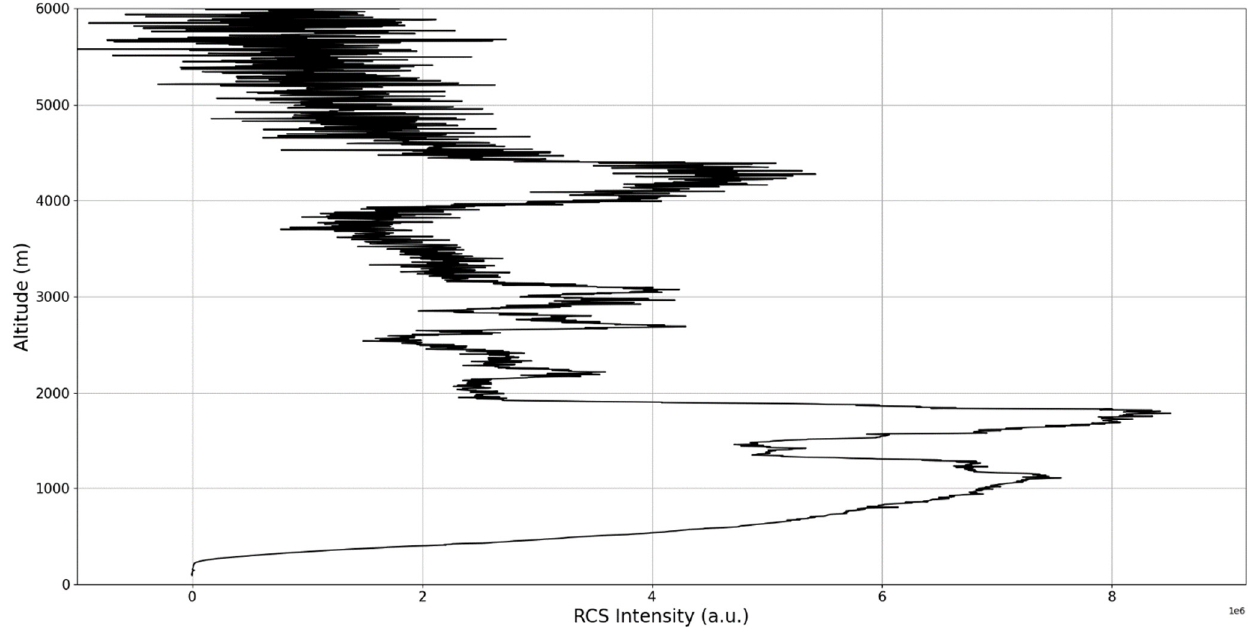
Figure 5. Zoomed-in RCS profile corresponding to point A.